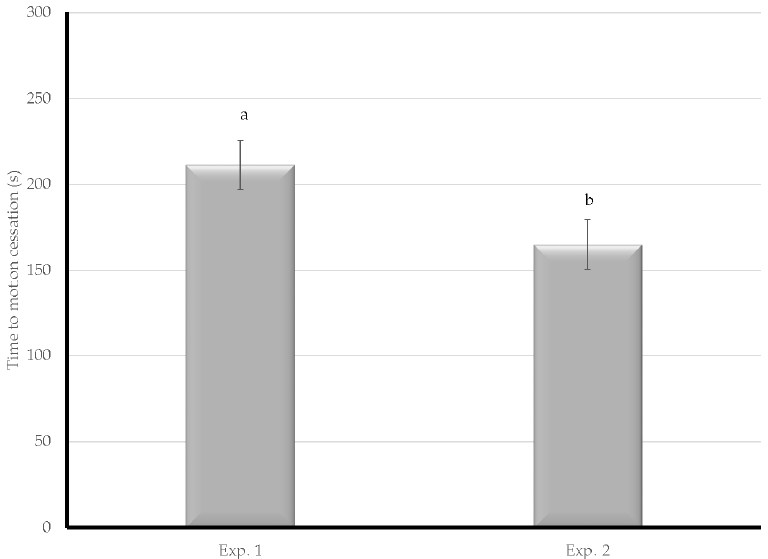
Figure 4. The time from treatment to cessation of movement of spent hens was compared between Experiments 1 and 2. Letters denote assigned connected letters report with differing letters representing statistical